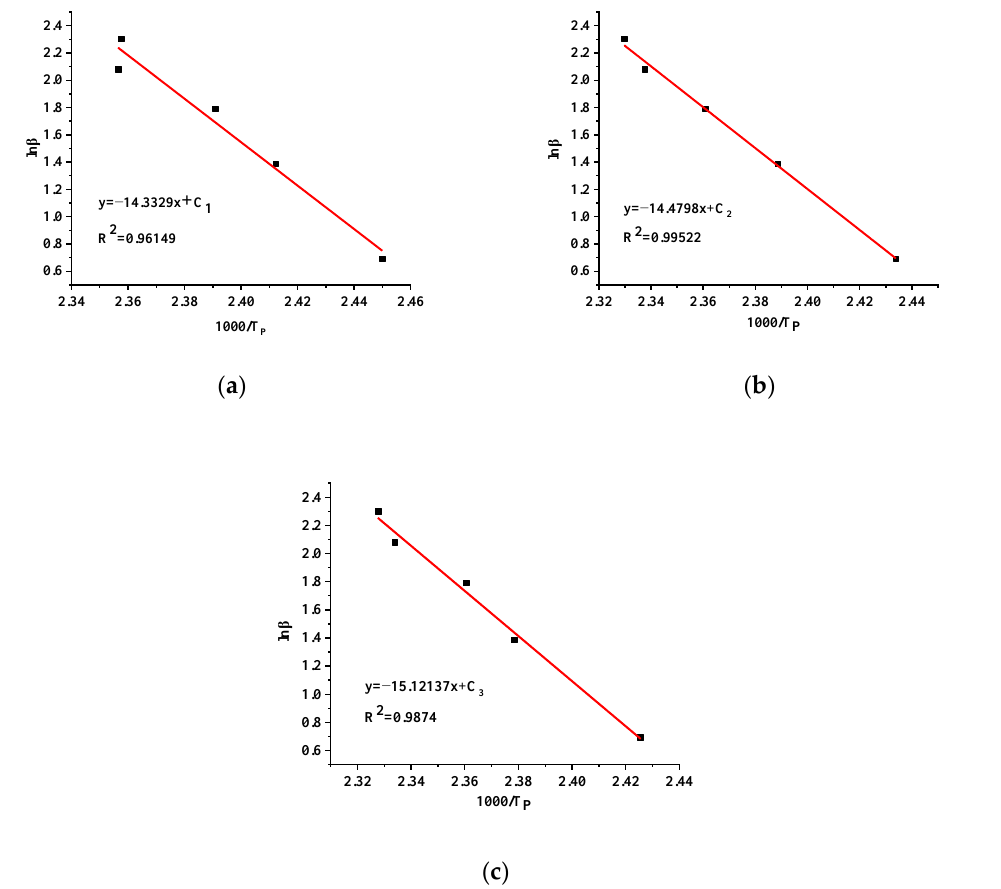
Figure 7. Fitting curves of pure TBPTMH ( a ) and mixtures with H 2 SO 4 and NaOH ( b , c ) by Coats–